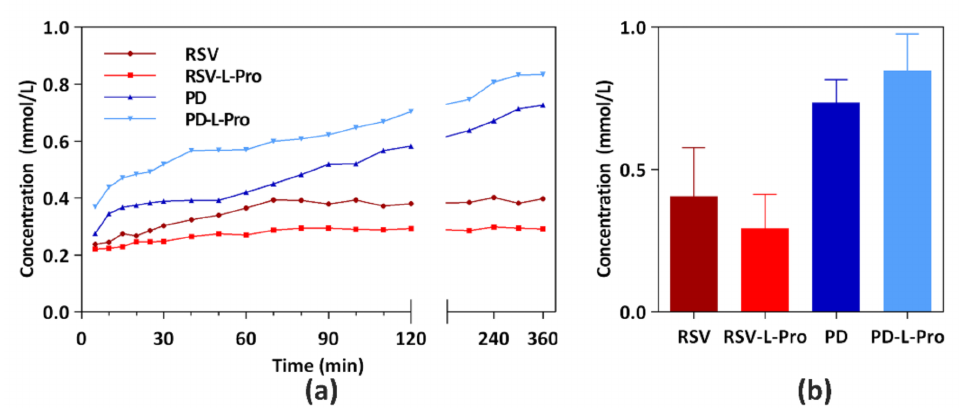
Figure 9. ( a ) A summary of the solubility profile and ( b ) solubility data upon equilibrium for 24 h of RSV, PD, and the crystals of RSV-L-Pro and PD-L-Pro in H 2 O at pH 7.0. Data are expressed as average values from three replicates.